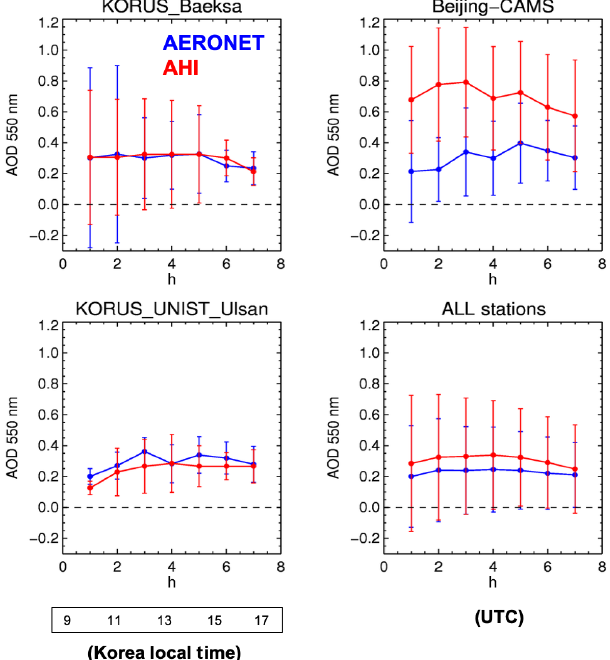
Figure 7. Median AOD at 550nm in each of seven time-of-day bins corresponding to 10:00 to 16:00 Korean standard time. Shown are three individual AERONET stations and also (lower right) the results of binning all of the AERONET stations across the full- disk image as shown in Fig. 3. Red indicates AOD derived from AHI using the new DT algorithm. Blue indicates AOD measured by AERONET. The statistics were calculated from the collocation database such that each bin contains the same number of observa- tions from AHI and AERONET taken at the same time, although the number of observations in each diurnal bin will differ. Vertical error bars represent 1 standard deviation among different days for the same